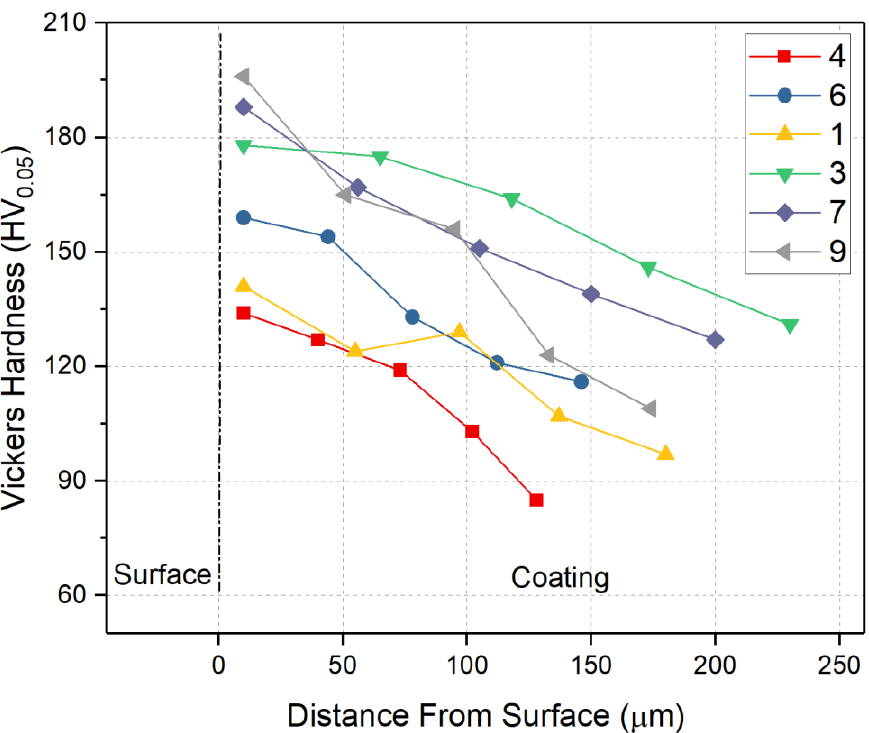
Figure 10. Cross-section microhardness profiles of coatings from surface to interface.